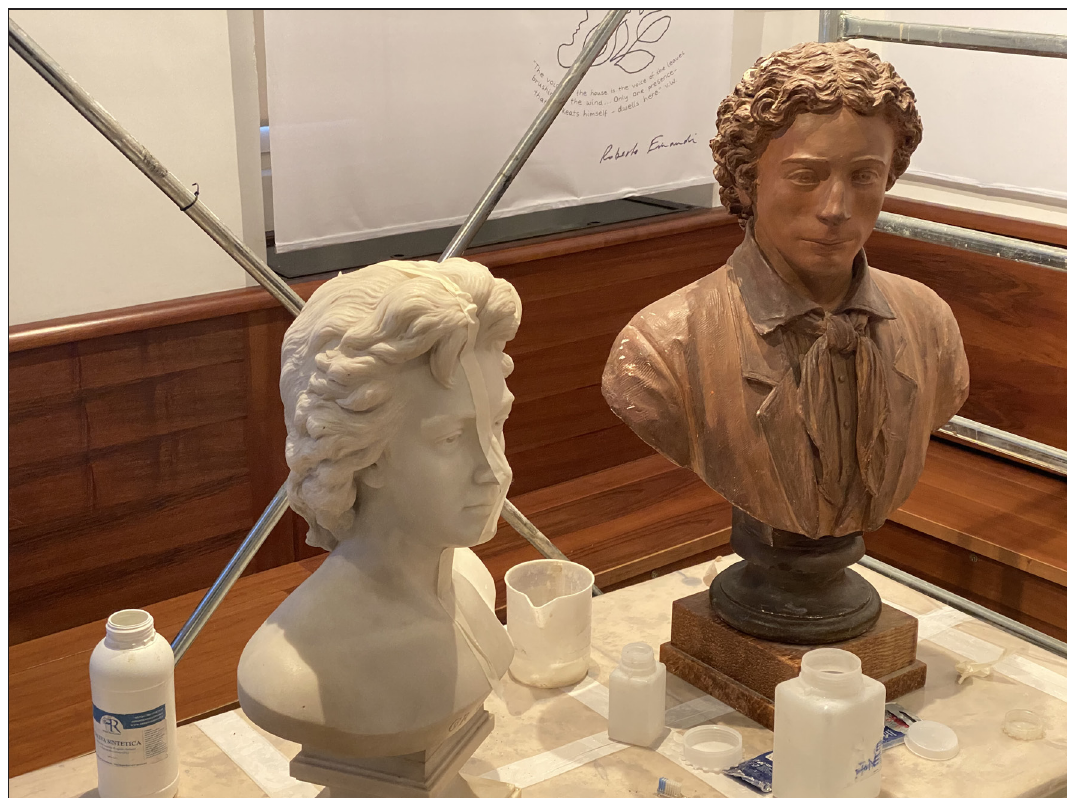
Fig. 1 : Busts under restoration during lockdown: (left) P. B. Shelley by Mozes Ezekiel; and